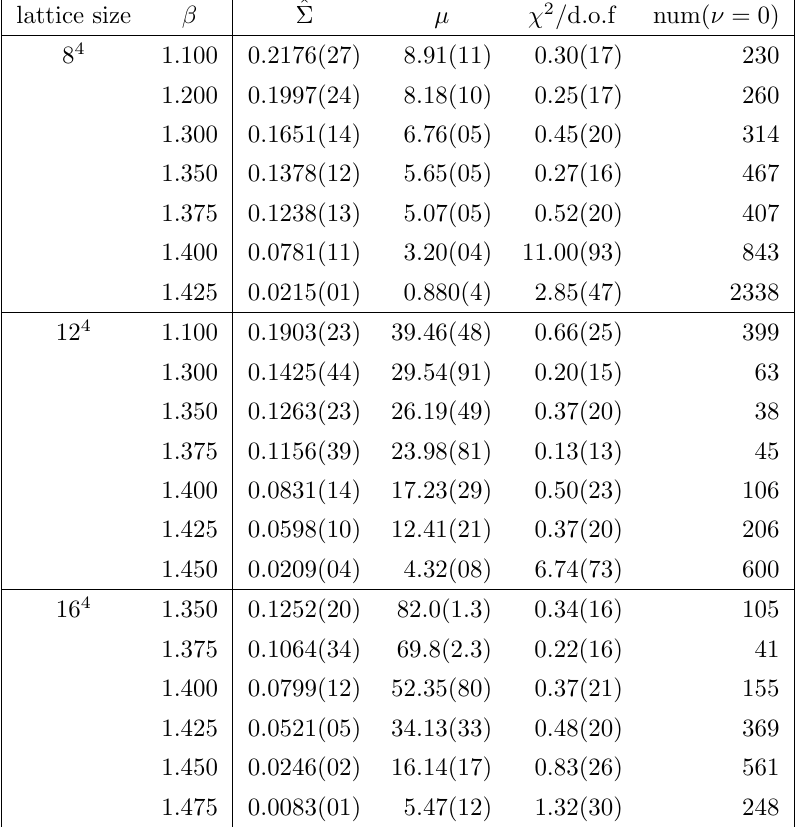
Table 2 . Fit result of ^(cid:6), chiral condensate in the lattice unit, together with the